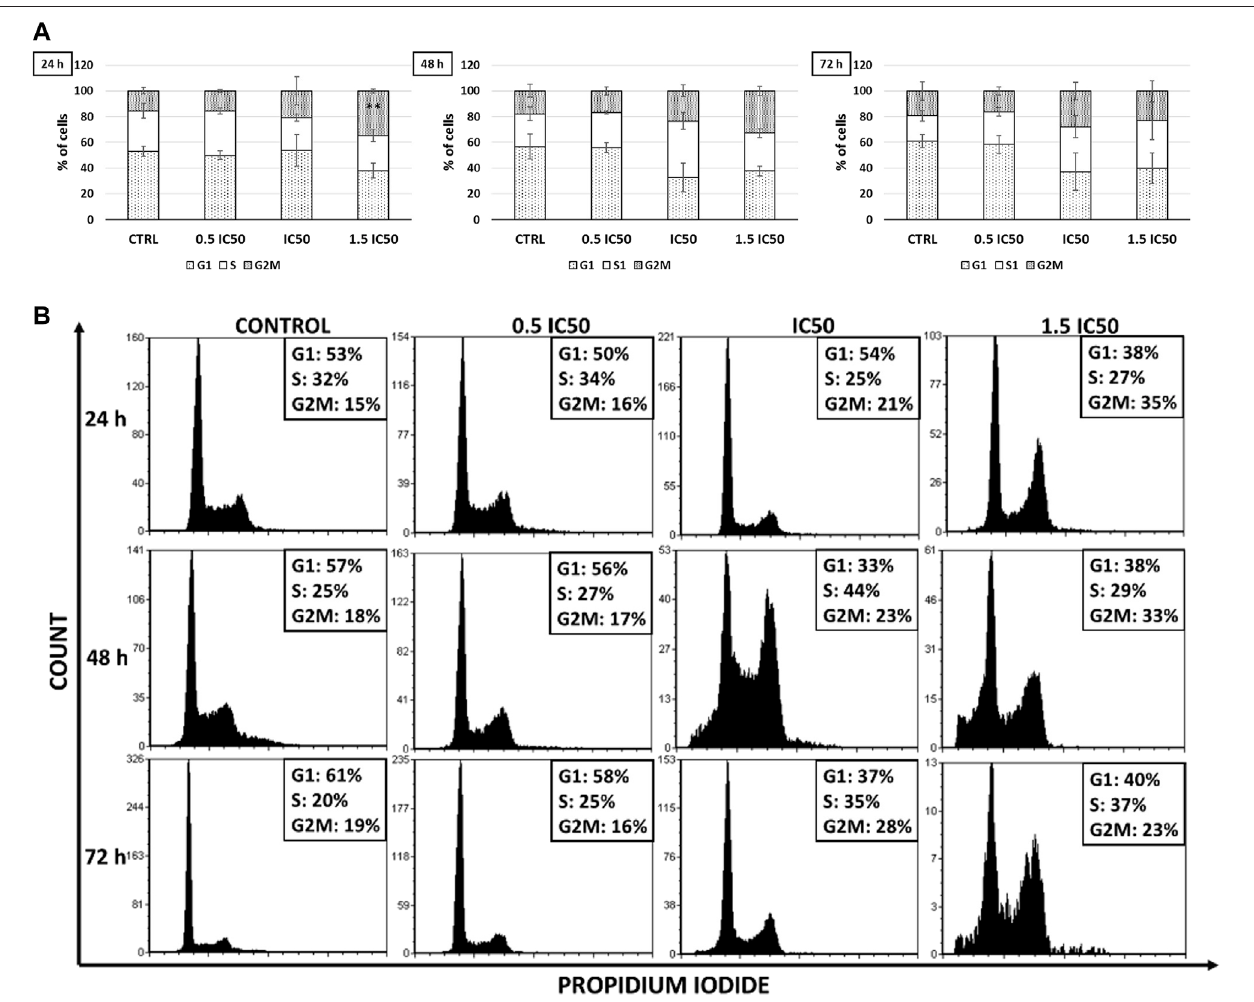
FIGURE 5 | The effect of CX-4945 on cell cycle progression in the A-549 cell line. Cells were treated with 15.5, 31, and 46.5 µM CX-4945 for 24, 48, or 72 h and then fi xed and stained with PI. (A) Distribution of the cells in different phases of the cell cycle were determined by fl ow cytometry and analyzed with FCS Express 5 Flow software to determine the percentage of cells in each phase of the cell cycle. Statistically signi fi cant results for the cells treated from the control cells by Student ’ s t-test were indicated by asterisks as follows: * p ≤ 0.05, ** p ≤ 0.01, and *** p ≤ 0.001 (see Materials and Methods ). (B) Exemplary DNA histograms of the A-549 cell line.